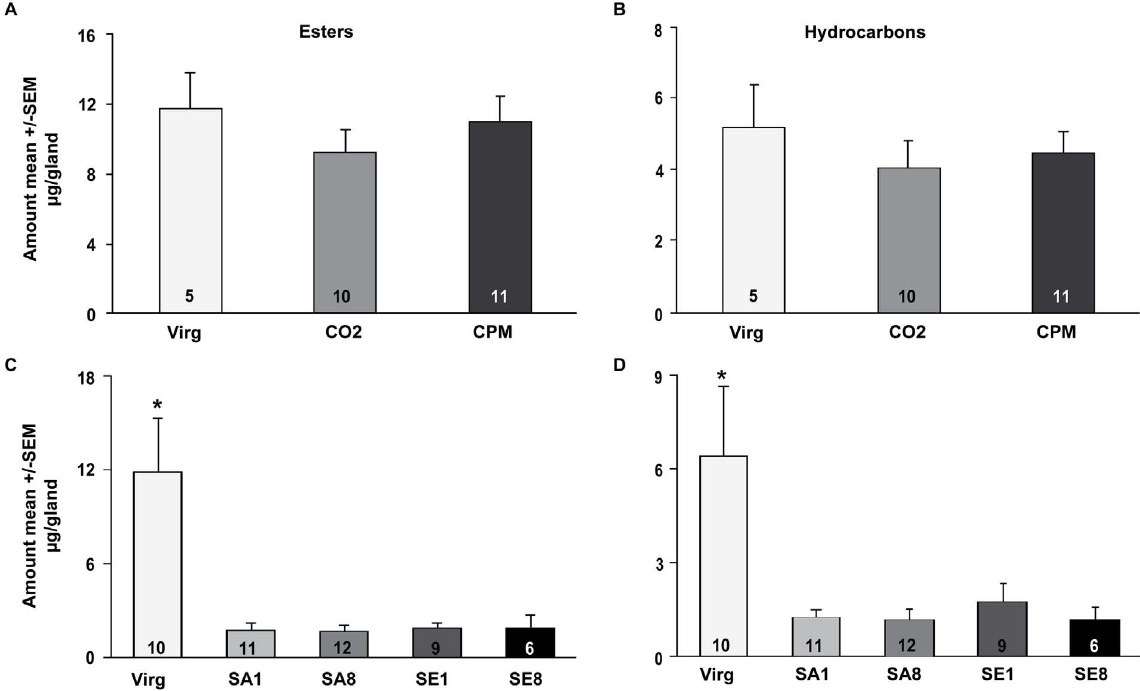
Figure 1. Queen Dufour ’ s gland pheromone production. There was no significant effect of CO 2 treatment or manipulation on the ( A ) amount of esters produced per queen gland (data not transformed, ANOVA: F 2,23 =0.62, P=0.55) or ( B ) amount of hydrocarbons produced per queen gland (data not transformed, ANOVA: F 2,23 =0.43, P=0.66). There was a significant effect of insemination on ( C ) the amount of esters produced per queen gland (ANOVA on log2-transformed data: F 4,43 =9.68, P , 0.0001; asterisk indicates significant difference) and ( D ) the amount of hydrocarbons produced per queen gland (ANOVA on log2-transformed data: F 4,43 =0.53, P=0.001). The mean 6 SEM is shown for the raw data, numbers in bars denote the number of queens in the group. Abbreviations are as follows: Virg = virgin, CO 2 = carbon dioxide, CPM = CO 2 –treated and physically manipulated, SA1 = saline 1 m l, SA8= saline 8 m l, SE1 = semen 1 m l, SE8= semen 8 m l.